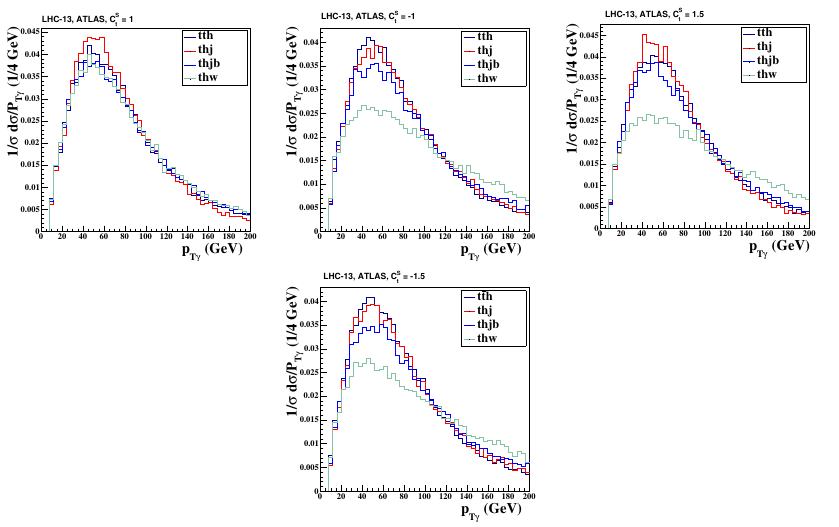
Figure 8 . The P T distributions for the t (cid:22) th and thX processes in the h ! (cid:13)(cid:13) channel at LHC- (cid:13) 13 taking C S = +1 ; (cid:0) 1 ; +1 : 5 ; (cid:0) 1 : 5 from left to right. We use the Delphes ATLAS template for t detector simulations.